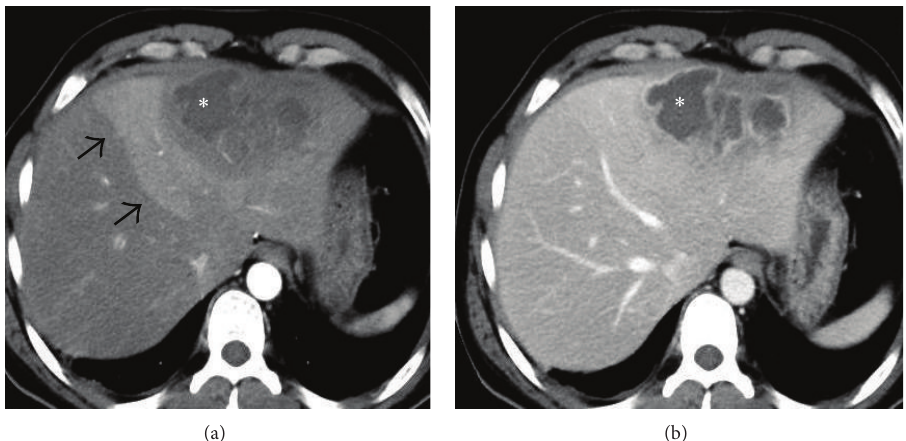
Figure 36: Axial CECT images obtained in the arterial (a) and venous (b) phases showing an abscess in the left lobe (asterisk) which had caused acute thrombosis of the left portal vein (pylephlebitis). Associated hepatic artery buffer response is seen in the form of increased enhancement of the left hepatic lobe in the arterial phase (arrows in (a)) which becomes essentially isodense on the portal venous phase.